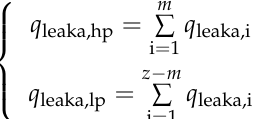
Figure 4. Schematic diagram of leakage flow of piston/cylinder interface.